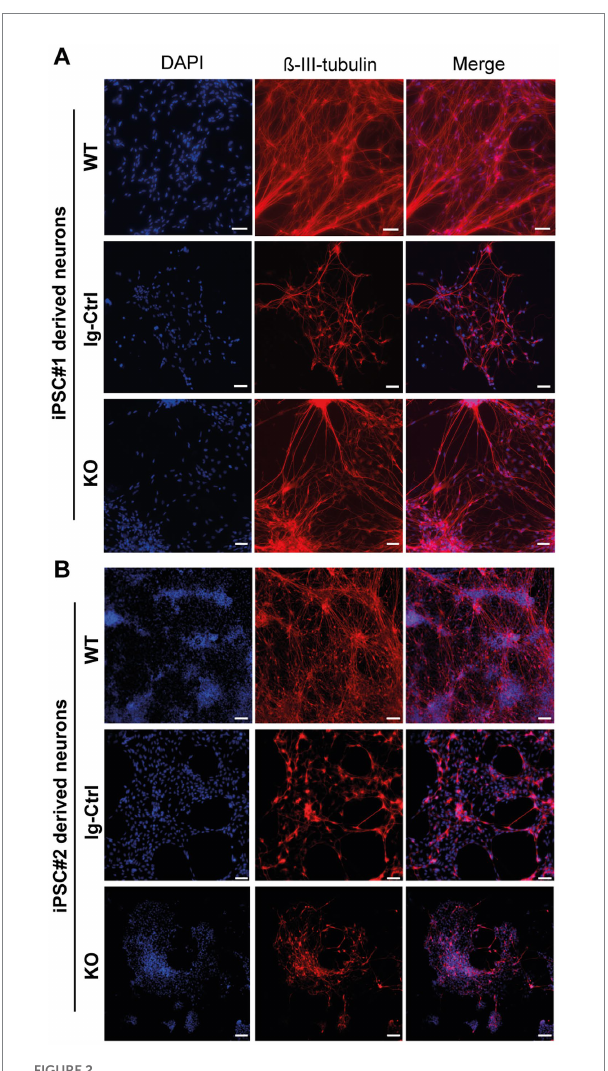
FIGURE 2 ß-III-tubulin stainings of iPSC-derived neurons. (A) Cells derived from iPSC#1. (B) iPSC#2-derived neurons. All generated cell lines contain extensive axonal networks. Scale bar 100 μ